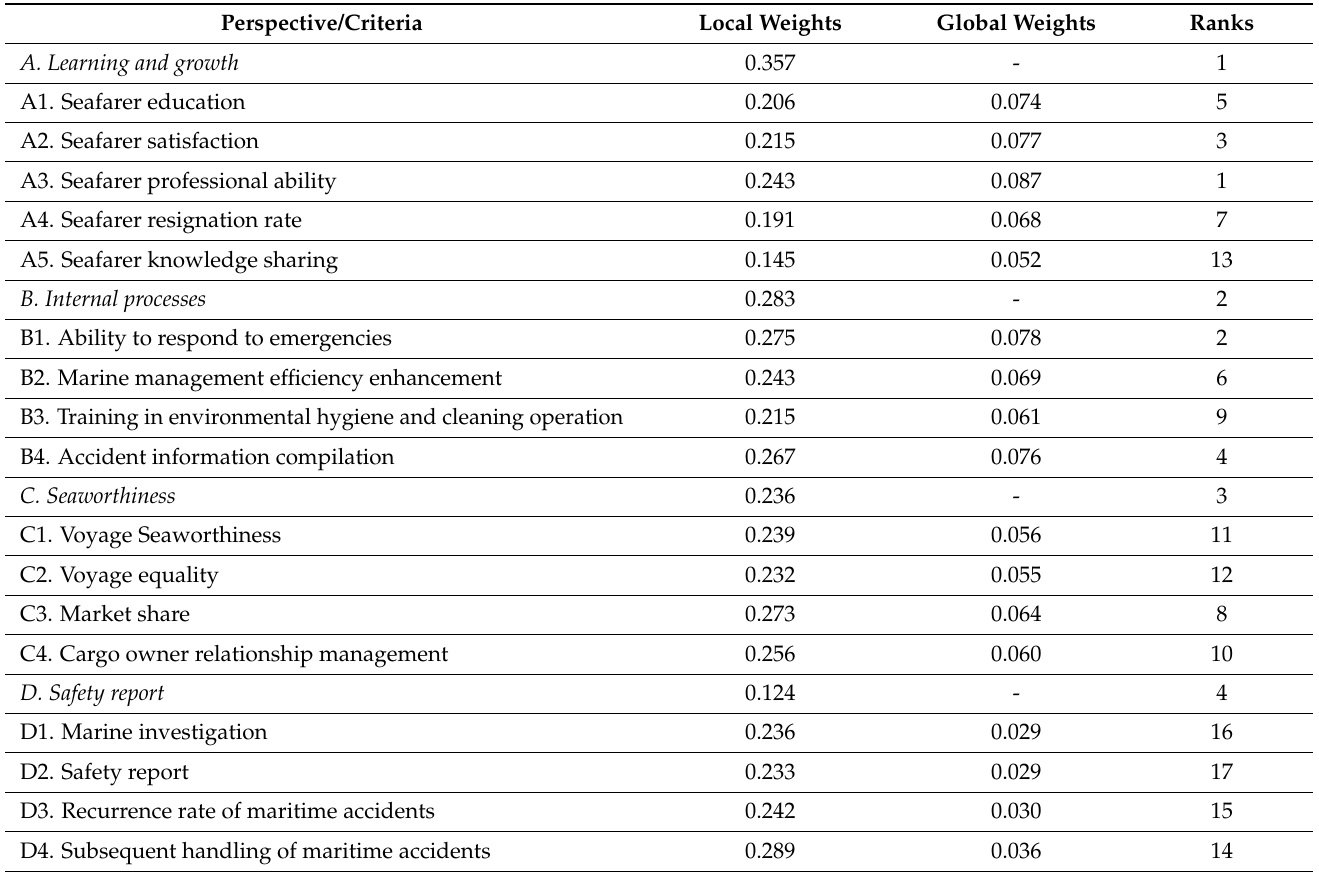
Table 4. Weights and ranking for the maritime accident risk